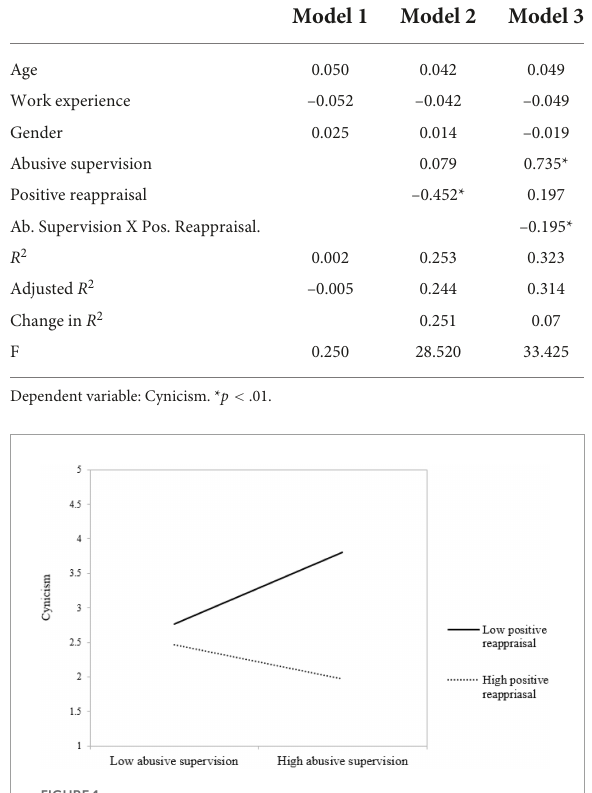
TABLE 3 Results of hierarchical moderated regression analyses for positive reappraisal.